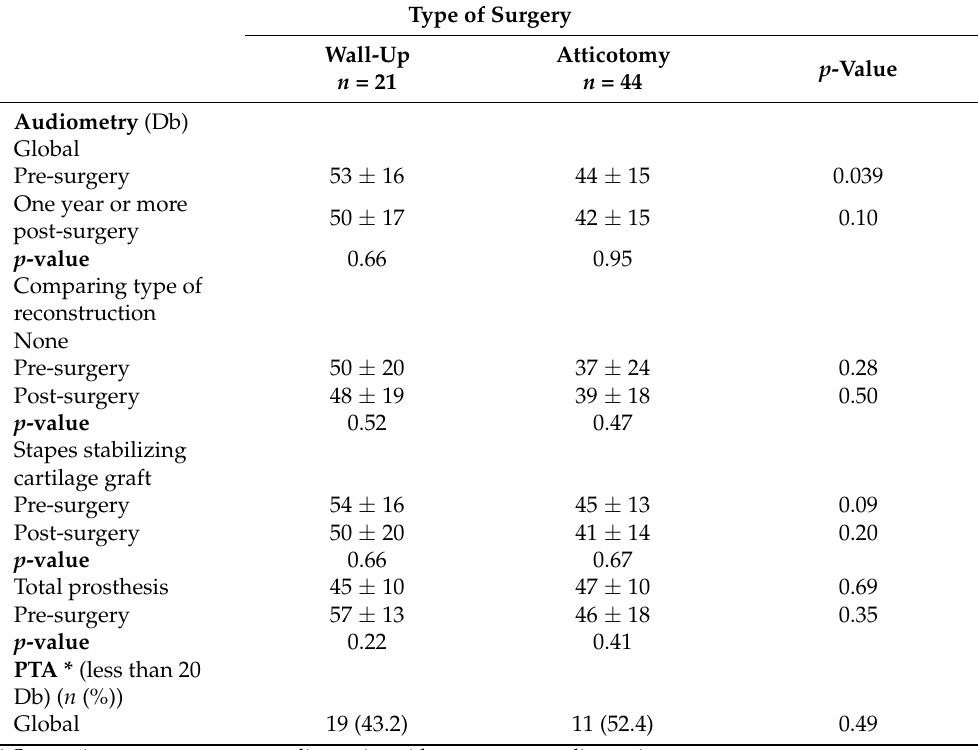
Table 3. Audiological results comparing types of surgery and